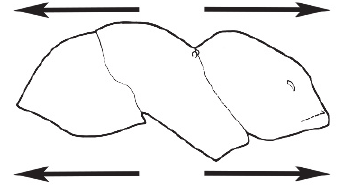
dorsum of mesonotum weakly convergent to subparallel anteriorly) ......... 27